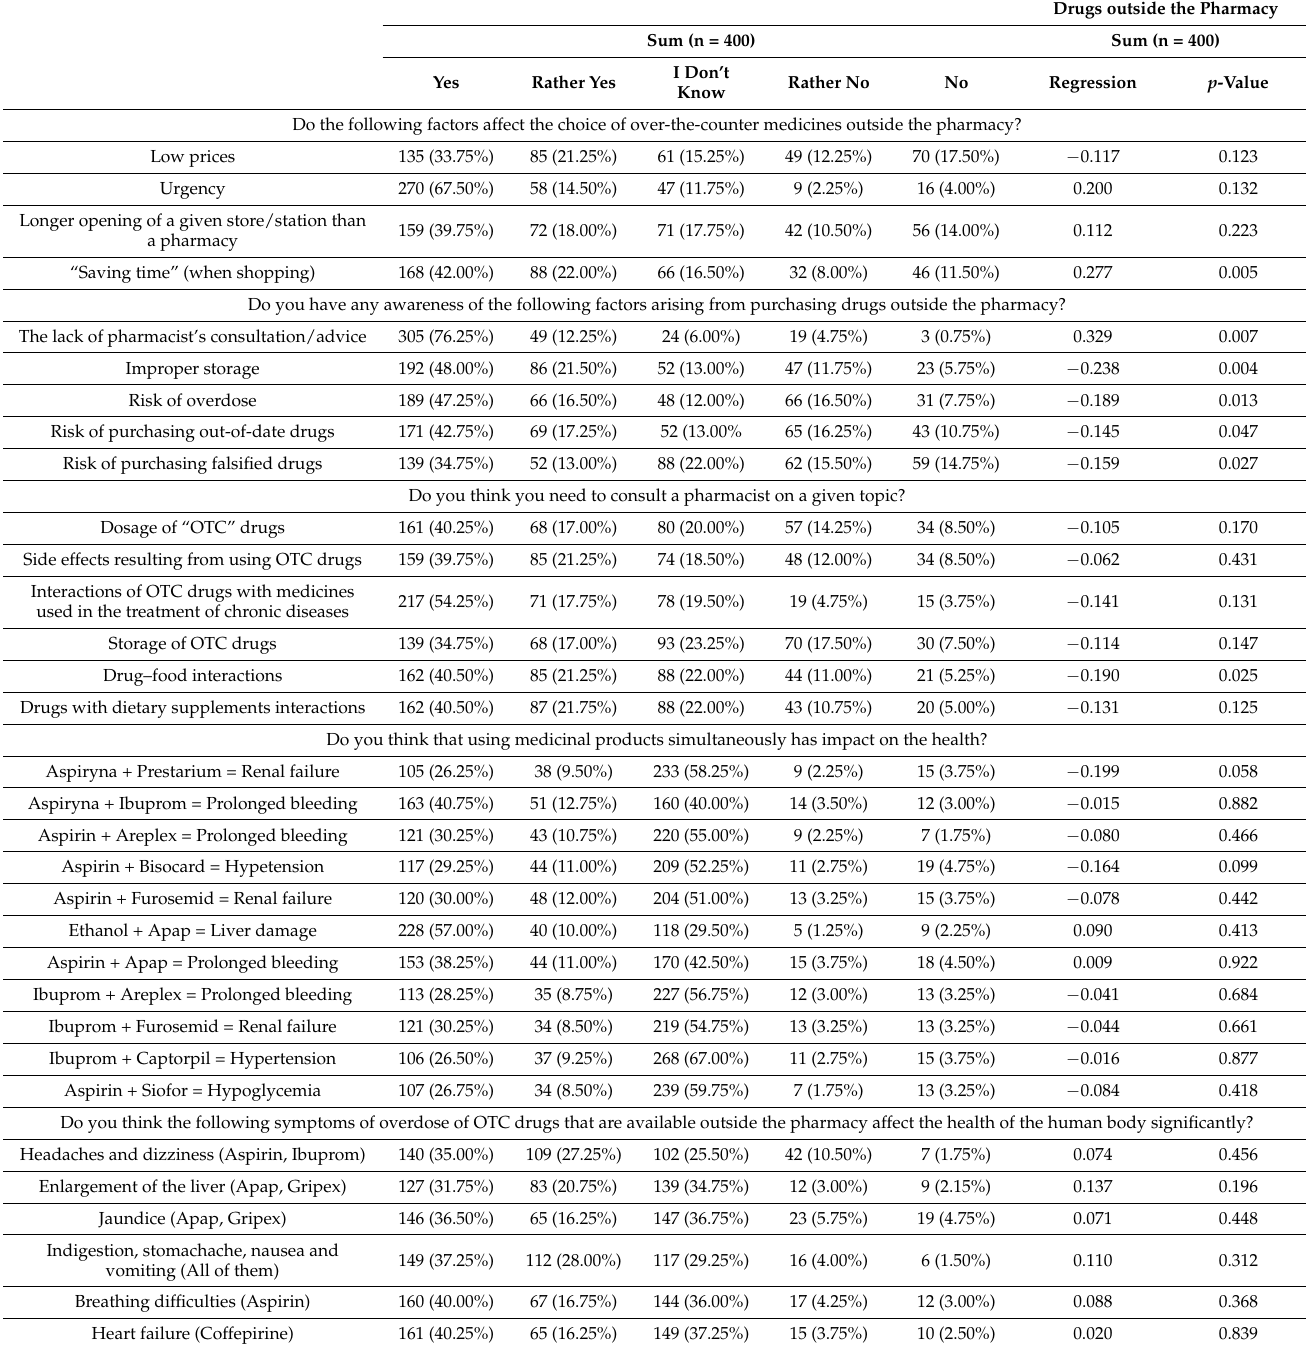
Table 2. Characteristics of responders in terms of study with